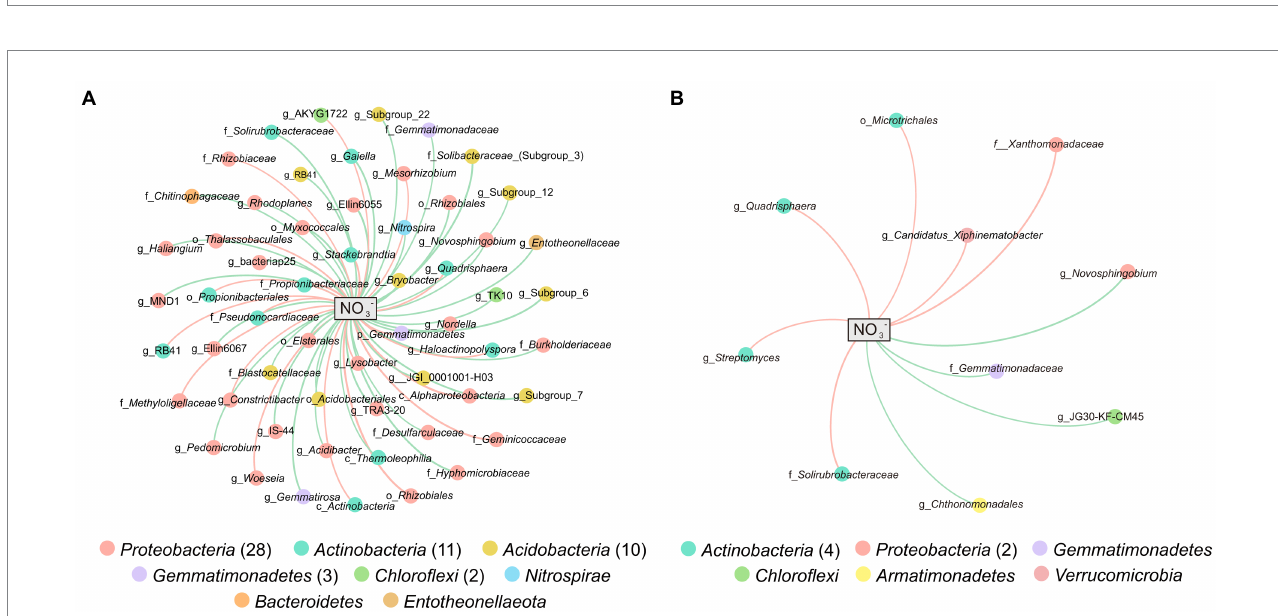
FIGURE 4 Networks between microbial genera and NO 3 − in weathered rocks (A) and sediments (B) . Nodes are colored by microbial phyla, and the connection edge represents a significant correlation (| r | > 0.5, p < 0.05) with NO 3 − based on pairwise Spearman’s correlations. Positive correlations are in red and negative correlations are in